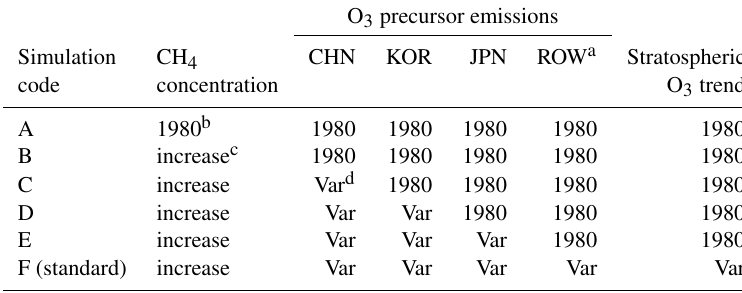
Table 2. Summary of the sensitivity simulations and the standard simulation.